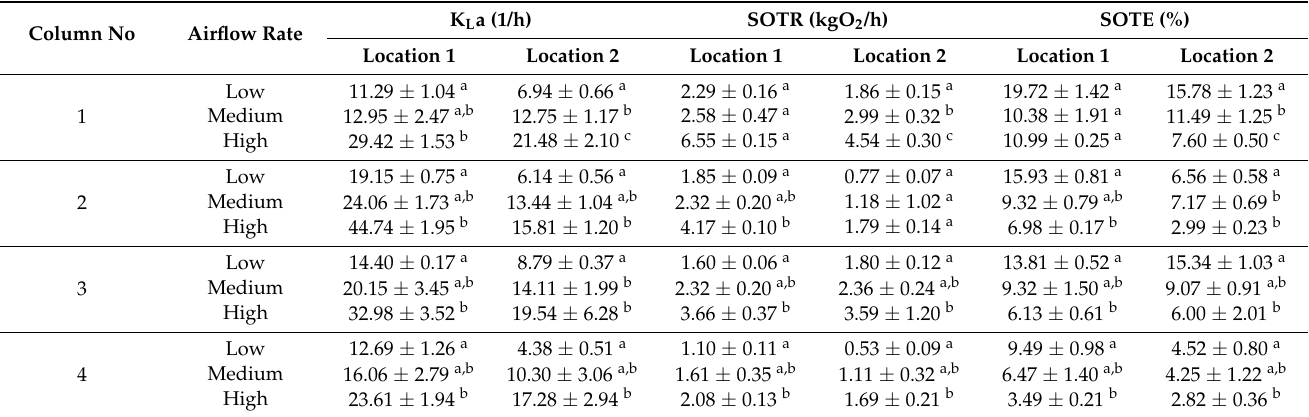
Table 2. Overall oxygen mass transfer coefficient (K L a), specific oxygen transfer rate (SOTR), and specific oxygen transfer efficiency (SOTE) for each configuration, airflow, and location.